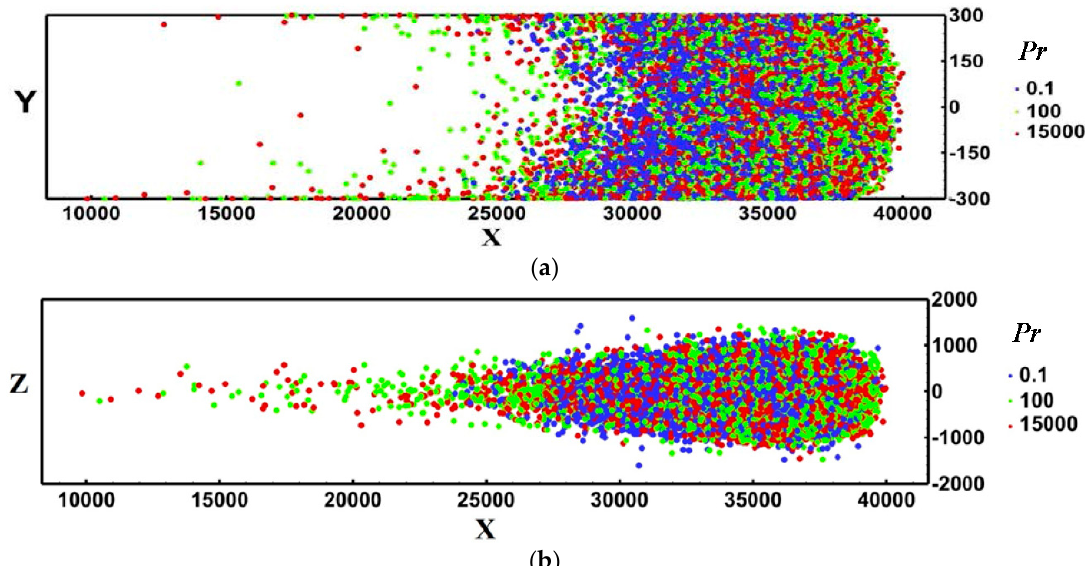
Figure 3. A view of the puff shape at t = 2000. ( a ) side view in the x - y plane; ( b ) top view in the x - z plane. Viscous wall units are used for space and time. plane. Viscous wall units are used for space and